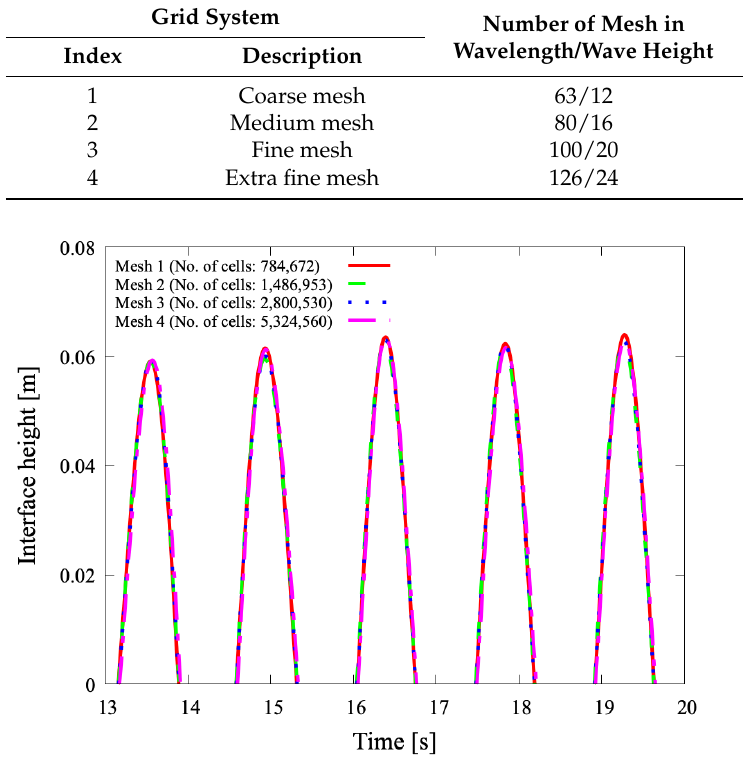
Figure 6. Time history of rogue wave’s elevation at focal point for four grids.